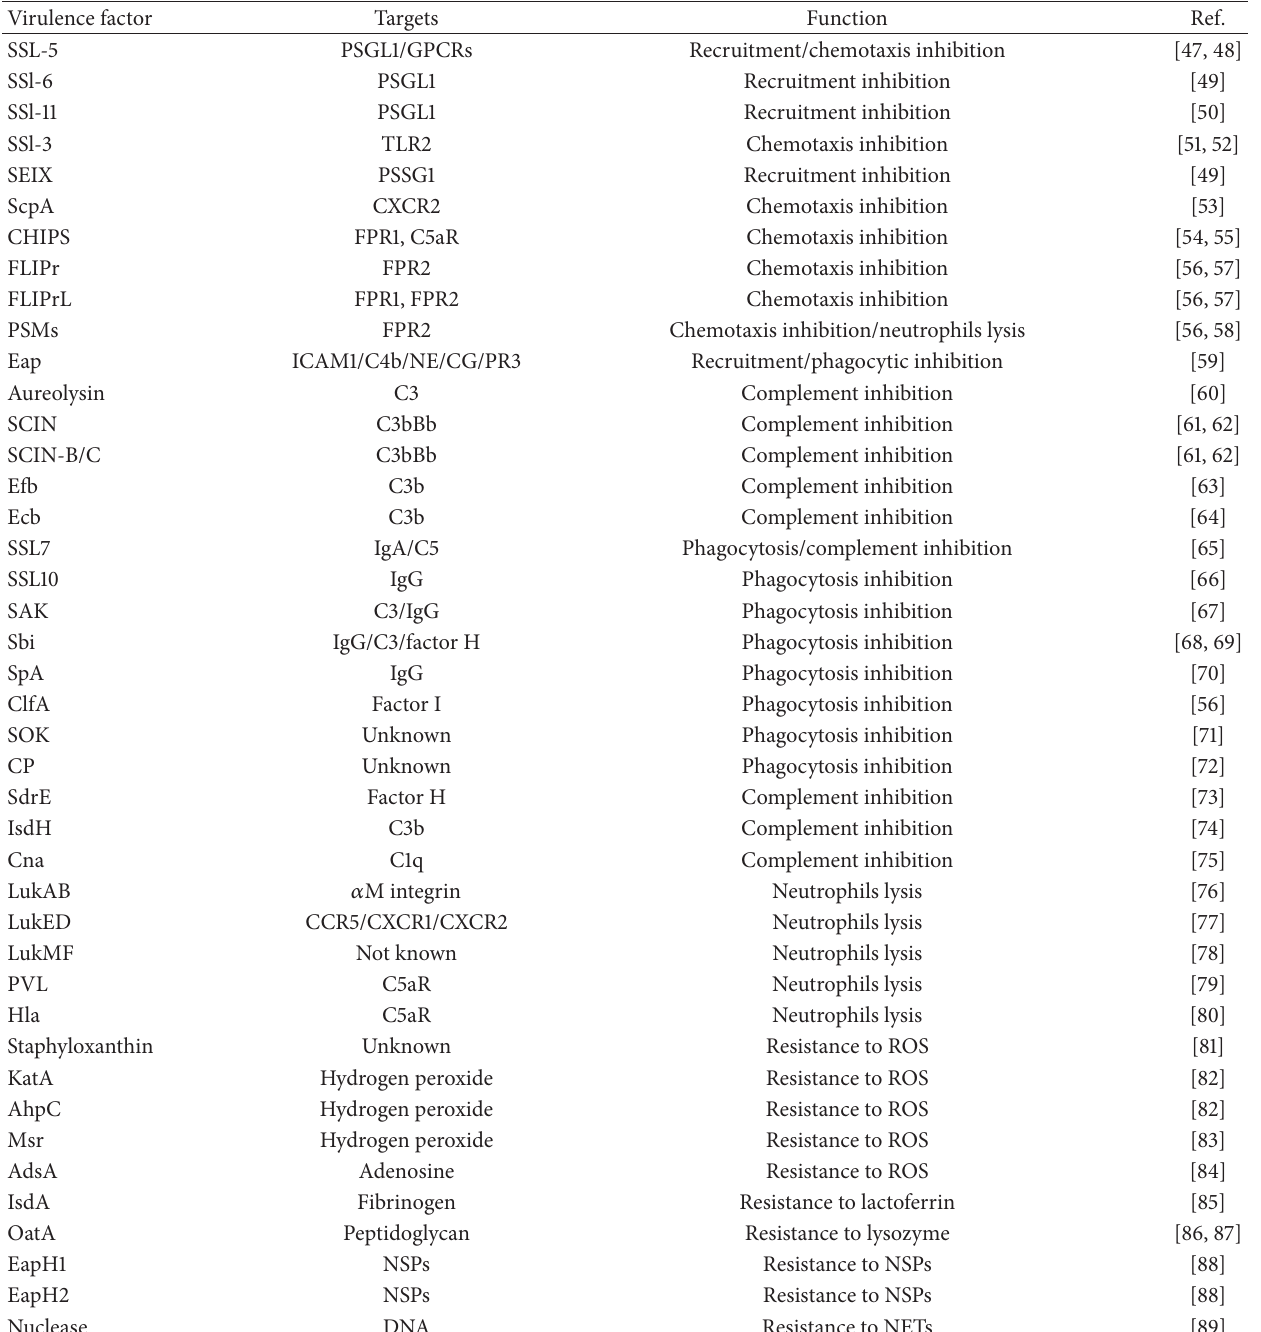
Table 2: Neutrophil antibacterial functions subverted by S. aureus . S. aureus produces a large suite of virulence factors to counteract specific neutrophil clearance mechanisms during the pathogenesis of invasive